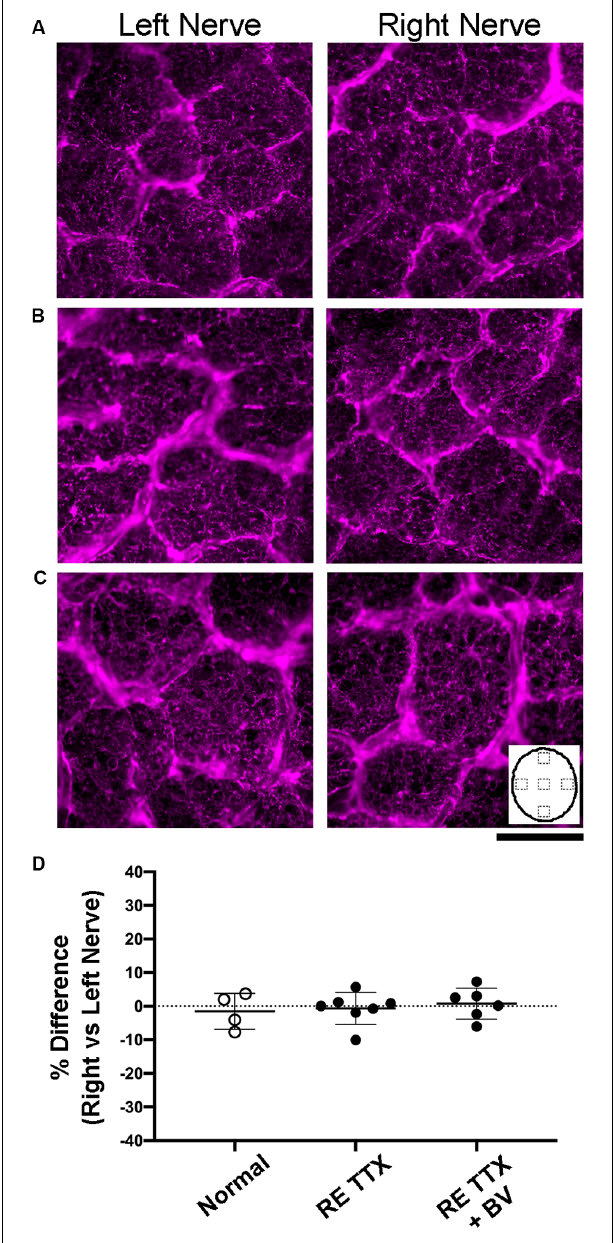
FIGURE 6 | Examination of glial fibrillary acidic protein (GFAP) labeling in cross-sections of the left and right optic nerves. Immunolabeling was comparable between sections of the left and right optic nerves in normal controls (A) , after 10 days of right eye inactivation (B) , and also when right eye inactivation was followed by binocular vision (C) . Quantification of labeling intensity (D) showed a balance between the left and right nerves, as was indicated by our ocular dominance calculation, that was not different across groups ( H = [3] = 0.50, p = 0.80; Dunn’s multiple comparison test: p > 0.05). Inset in C depicts an outline of the optic nerve cross-section to illustrate the location of labeling measurements. Scale bar = 250 microns.